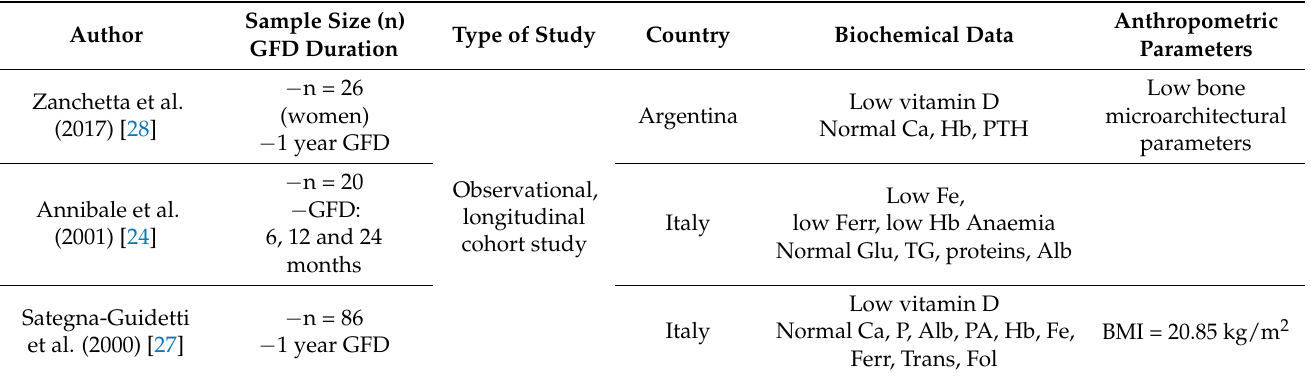
GFD: gluten-free diet. Ca: calcium. Hb: hemoglobin. PTH: parathyroid hormone. Fe: iron, Ferr: ferritin. Glu: glucose. TG: triglycerides P: phosphate. Alb: albumin. PA: pre-albumin. Trans: transferrin. Fol: folic acid. BMI: body mass